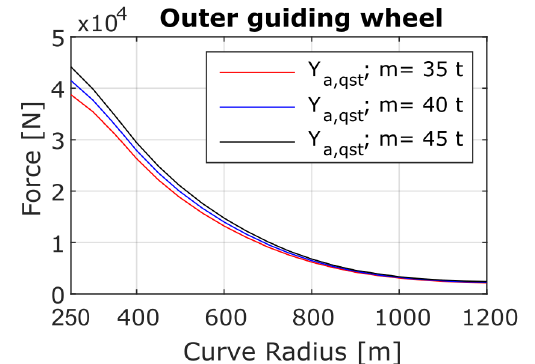
Figure 8. Dependence of the Y radius R for defined values of the vehicle body mass m .